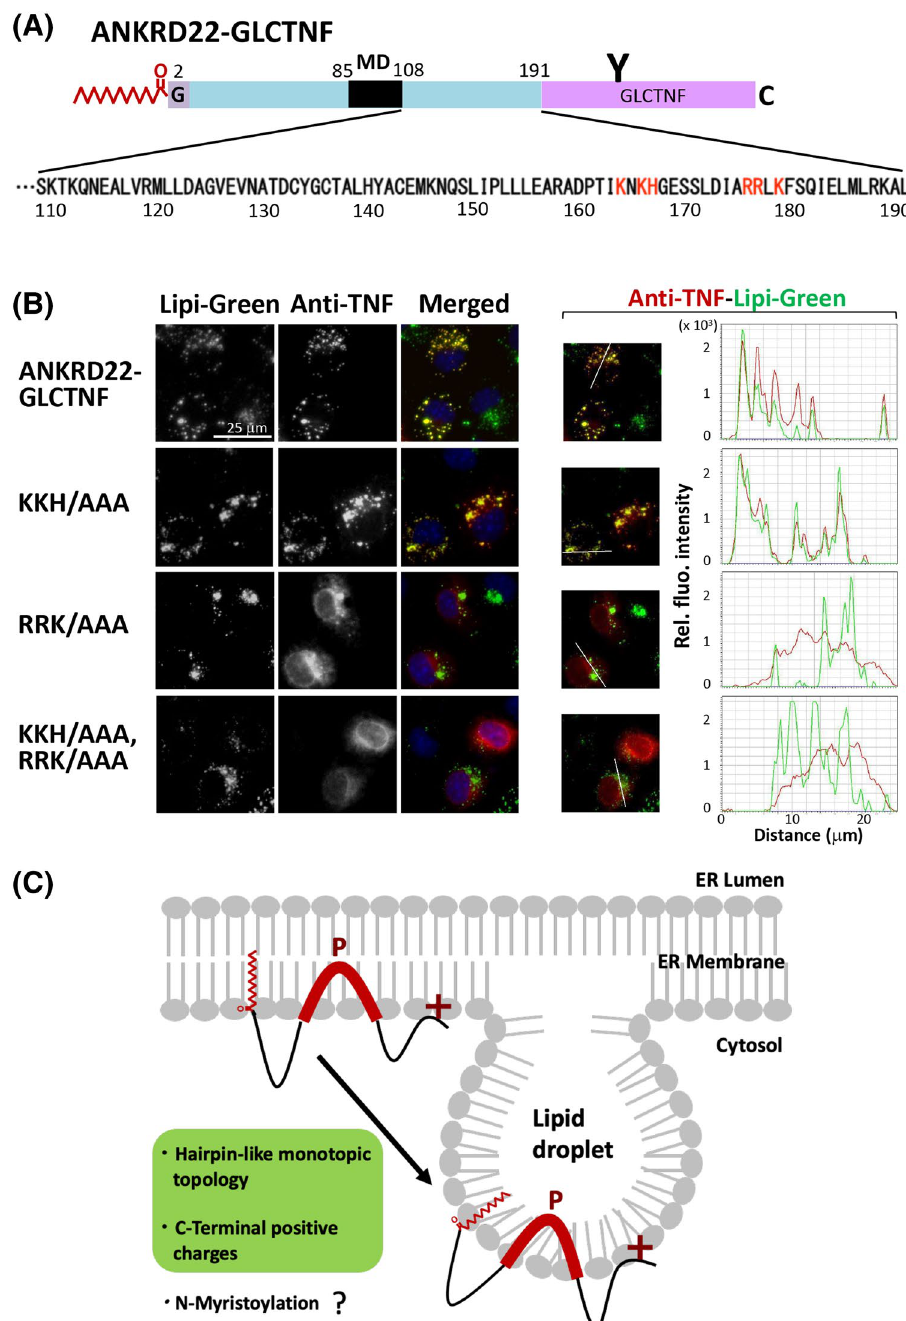
Figure 8. Positively charged residues in the C-terminal region are required for localization of ANKRD22 to LD. The role of the C-terminal cytosolic domain in the intracellular localization of ANKRD22 was assessed by immunofluorescence microscopic analysis using a series of substitution mutants of ANKRD22-GLCTNF. The names and structure of the ANKRD22-GLCTNF mutants analyzed in Fig. 8 are summarized in Supplementary Fig. S6[2]. The experiments were repeated 3 times and the similar results were obtained. A representative data was presented. ( A ) The amino acid sequence of the C-terminal cytosolic domain of ANKRD22 was shown. Two positively charged amino acid clusters were indicated by the red characters in the amino acid sequence. ( B ) Effects of substitution of the C-terminal positive-charge clusters on the intracellular localization of ANKRD22-GLCTNF. Fluorescence images obtained by immunofluorescence analysis and the results of the line profile analysis were shown. For the line profile analysis, corresponding line-scan graphs of the relative fluorescence intensities of green fluorescence (green line) and red fluorescence (red line) along the white line indicated in the merged images are shown. ( C ) The role of the hairpin-like monotopic membrane topology, C-terminal positively charged residues, and protein N-myristoylation on the LD localization of ANKRD22. Multiple factors, including the hairpin- like monotopic membrane topology, C-terminal positively charged residues, and protein N-myristoylation cooperatively affect the intracellular targeting of ANKRD22 from the ER to LD. Among them, the hairpin-like monotopic membrane topology and C-terminal positively charged residues are required for proper targeting of ANKRD22 to LD. As for protein N-myristoylation, it positively affects the LD localization. However, the exact roles of protein N-myristoylation in the intracellular localization and function of ANKRD22 are not